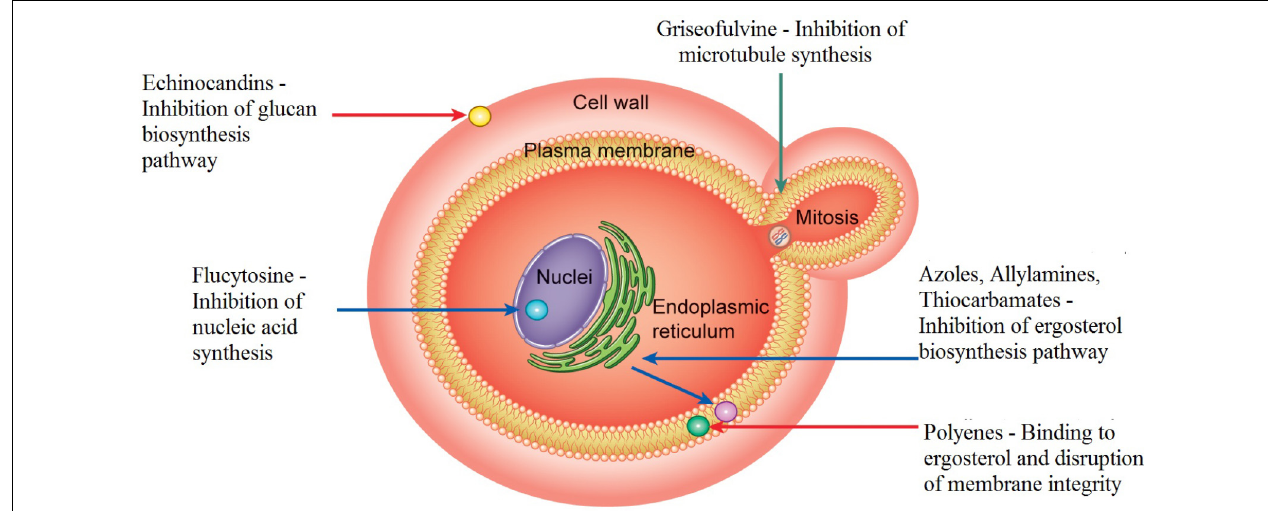
FIGURE 1 | Mechanisms of action of traditional antifungal agents on cellular targets. Azoles inhibit the ergosterol synthesis in the endoplasmic reticulum of the fungal cell. They act by interfering with the enzyme lanosterol 14- α -demethylase, involved in the transformation of lanosterol into ergosterol. Polyenes act in the fungal membrane by binding to ergosterol and causing disruption of the membrane structure promoting extravasation of intracellular constituents and, consequently, cell death. Flucytosine inhibits the thymidylate-synthetase enzyme interfering with DNA. Echinocandins inhibit (1,3) β - D -glucan synthase, thereby preventing glucan synthesis, which is present in the cell membrane of fungi. Allylamines and thiocarbamates inhibit the enzyme squalene-epoxidase, which participates in the synthesis of ergosterol. Griseofulvin acts by disrupting spindle and cytoplasmic microtubule production, thereby, inhibiting fungal